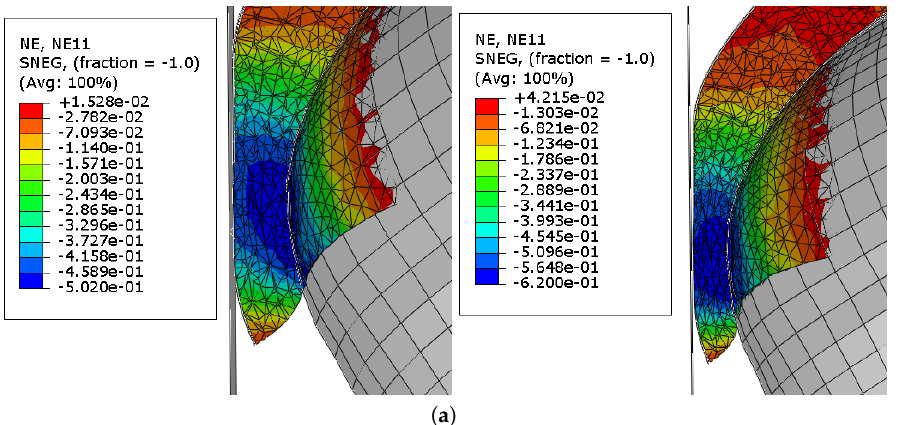
Figure 9. Maximum deformation of a liner with a thickness of 35 mm: ( a ) First impact. ( b ) Second impact.